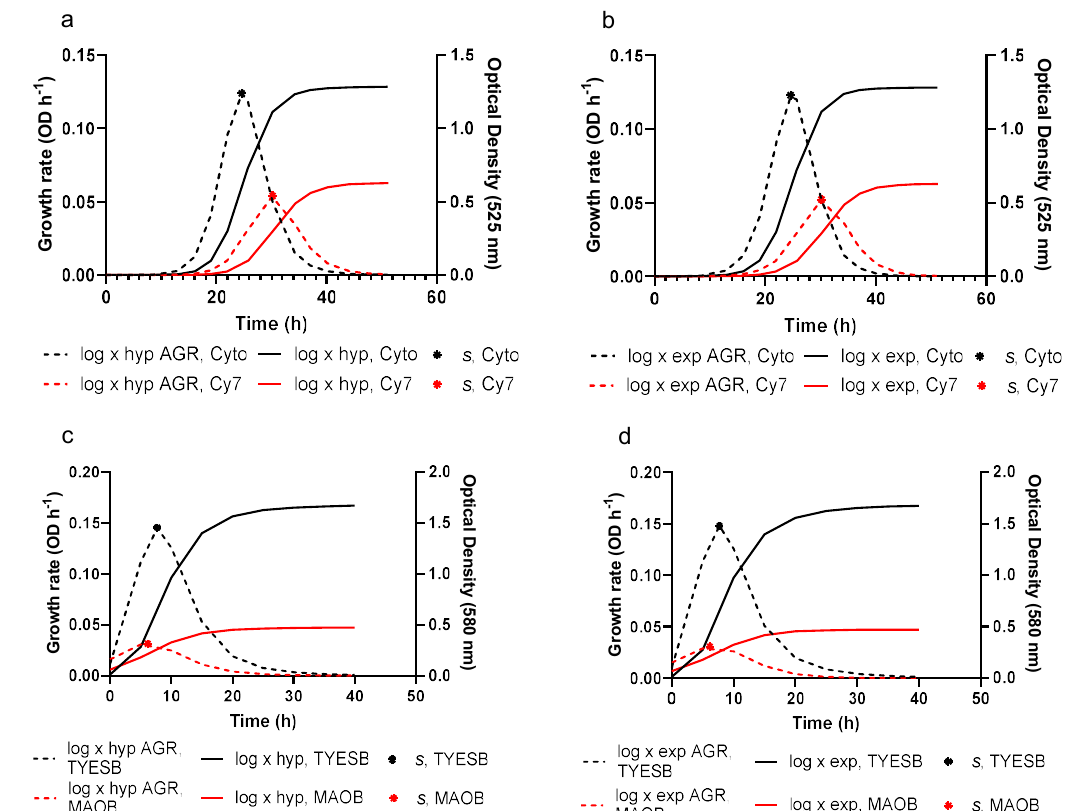
Figure 3. Comparison of actual growth rate (AGR), predicted growth and maximum actual growth rate ( s ) from liquid media resulting in highest and lowest maximum growth rates ( s ) from Study 1 and Study 2 when fitting log × hyp and log × exp. Panels ( a ) and ( b ) are taken from Study 1, and panels ( c ) and ( d ) from Study 2.